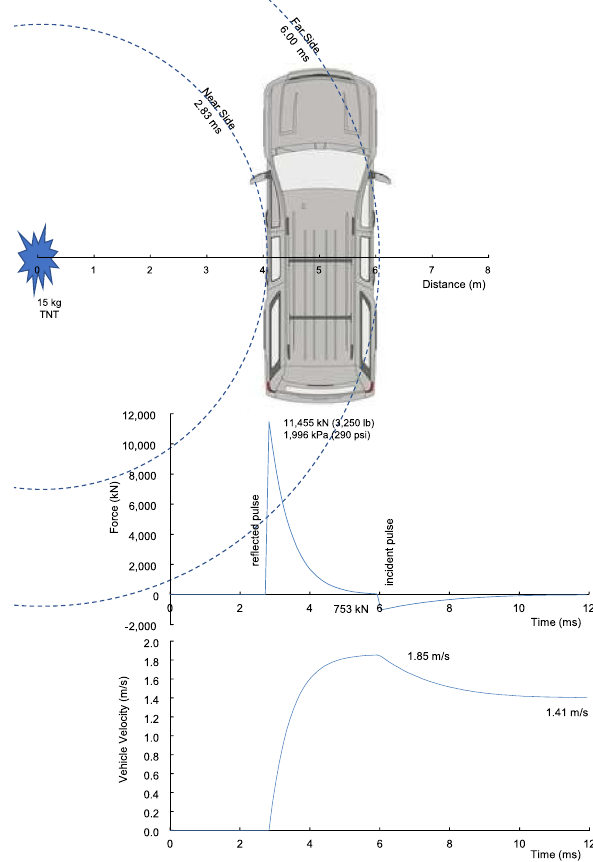
Figure 10. Force on the side of an armored passenger-vehicle and lateral velocity of the vehicle with 4 m stand- off from 15 kg